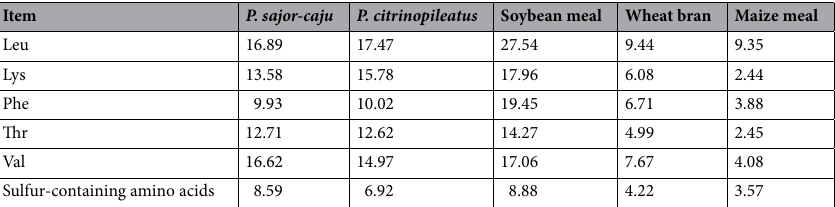
Table 5. Content (mg/kg) of essential amino acids in corn stover after 21 days of incubation with two white rot fungi ( P. or P . citrinopileatus ) compared to common